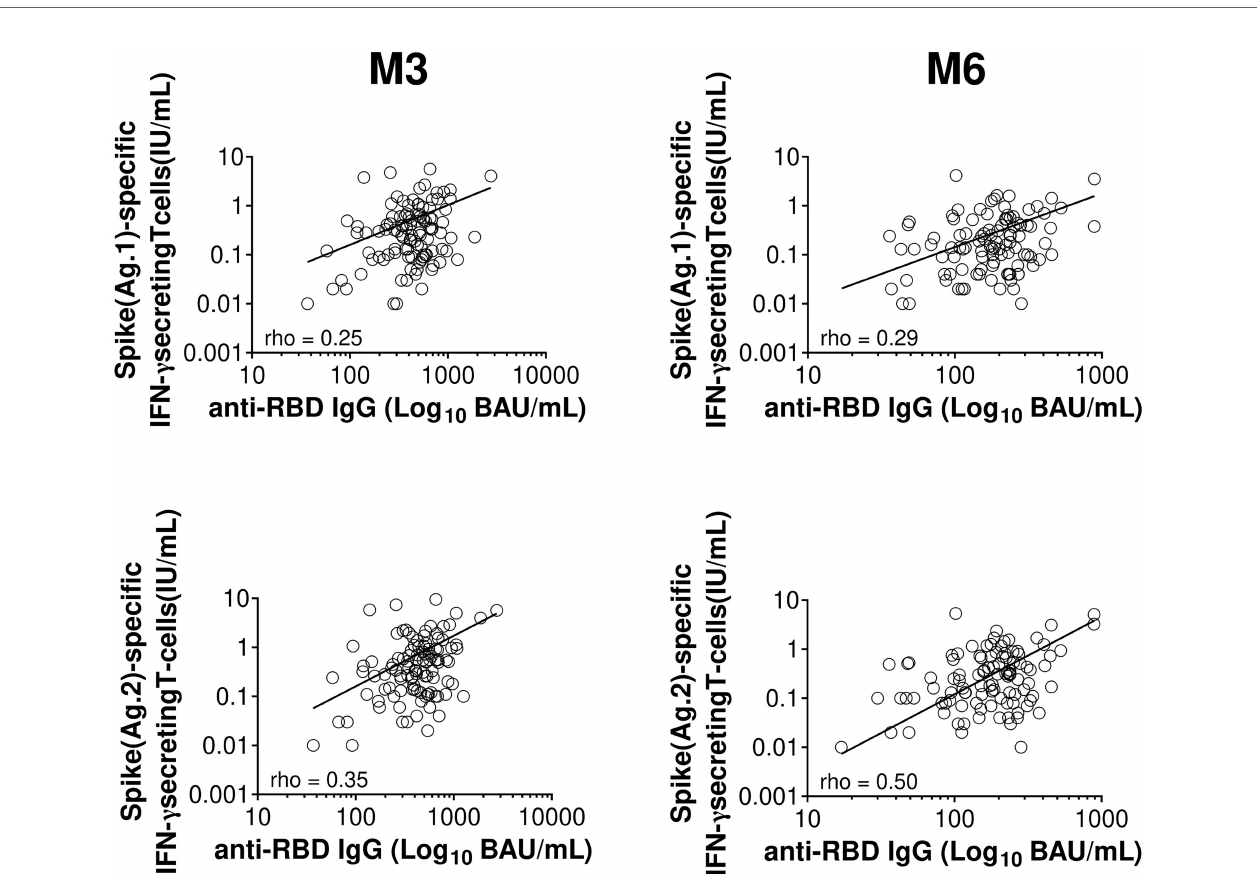
FIGURE 2 | Correlation between humoral and T-cell responses 3 and 6 months after the second dose of BNT162b2 mRNA vaccine. Scatter plot of speci fi c IFN- g response and anti-RBD IgG over time following BNT162b2 vaccination (n=108 at M3 and n=110 at M6). The full line represents the best fi t linear relationship of data. Pearson ’ s correlation coef fi cients are indicated (rho). BAU, binding-antibody unit; IFN- g , interferon gamma; IU, international unit; M3, 3 months post complete vaccination; M6, 6 months post full vaccination; RBD, receptor-binding